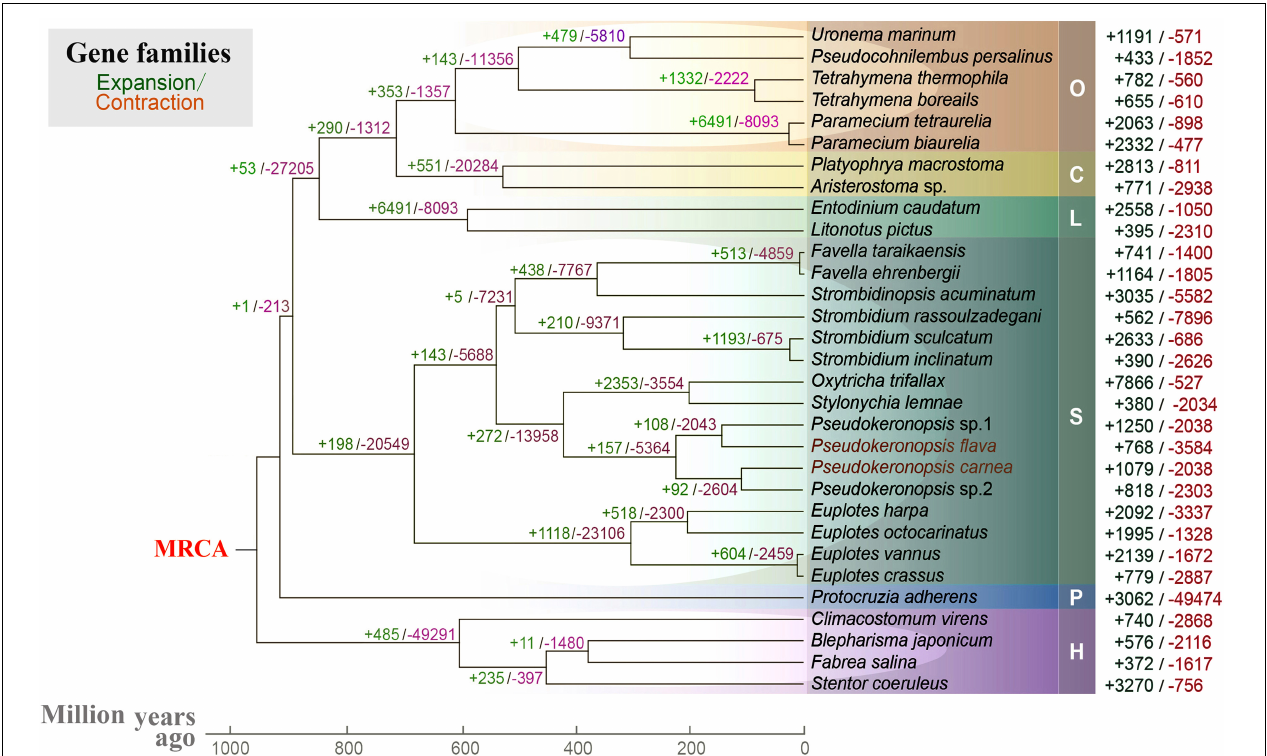
FIGURE 4 | Gene family evolution analysis of 31 ciliates based on 238 orthogroups. Green and red numbers represent the expanded or contracted gene families in each branch, respectively. MRCA, most recent common ancestor. O, class Oligohymenophorea; C, class Colpodea; L, class Litostomatea; S, class Spirotrichea; P, class Protocruzia; H, class Heterotrichea; M, class